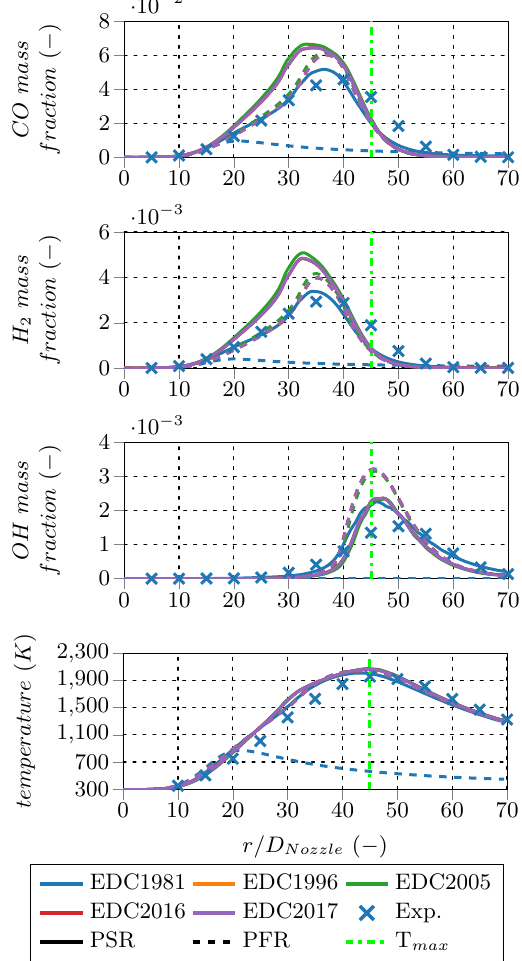
Figure 9. Centerline profiles of intermediate species (CO, H 2 , and OH) mass fractions and temperature (T) of flame D for all EDC model variations compared to the experimental data from [22]. Not all EDC versions are visible due to overlapping